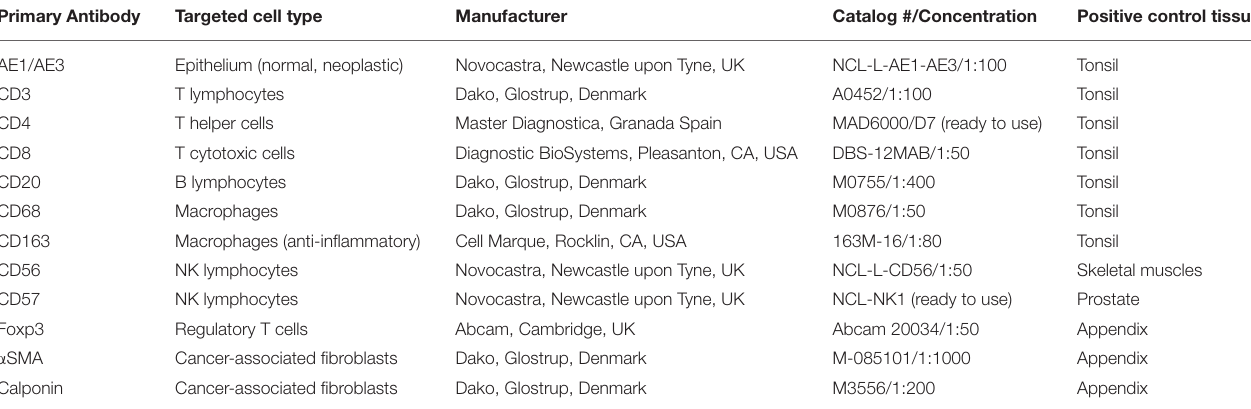
TABLE 1 | Antibodies used for identification of immune cells and cancer-associated fibroblasts. Primary